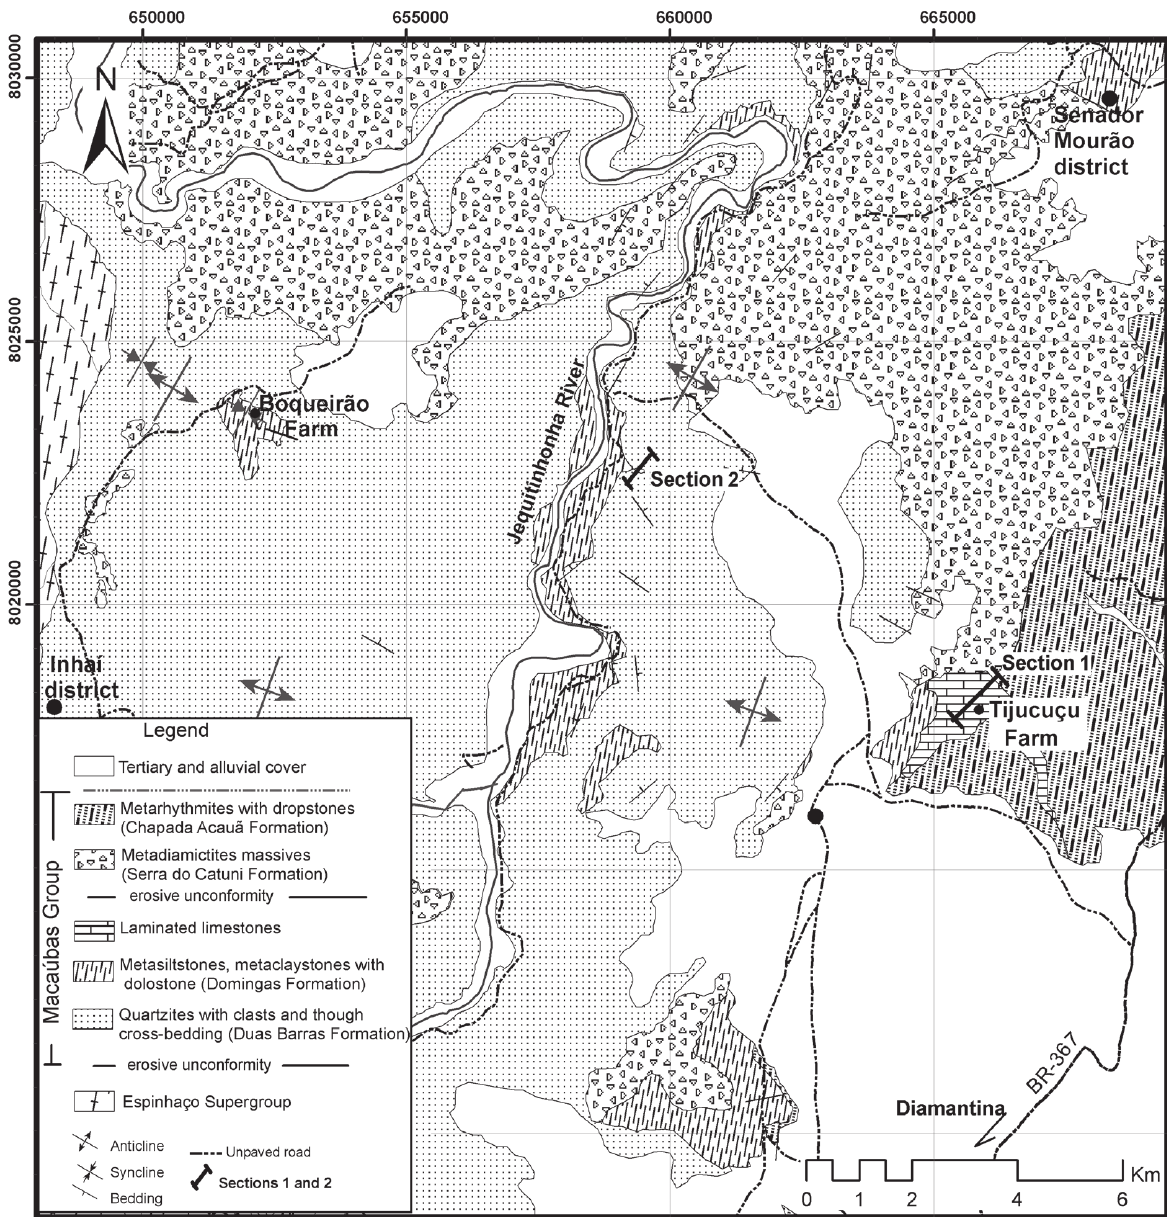
Figure 2 - Geological sketch map of the northeastern part of the Espinhaço Ridge. The location of the investigated sections (sections 1 and 2) are indicated (modified from Fraga